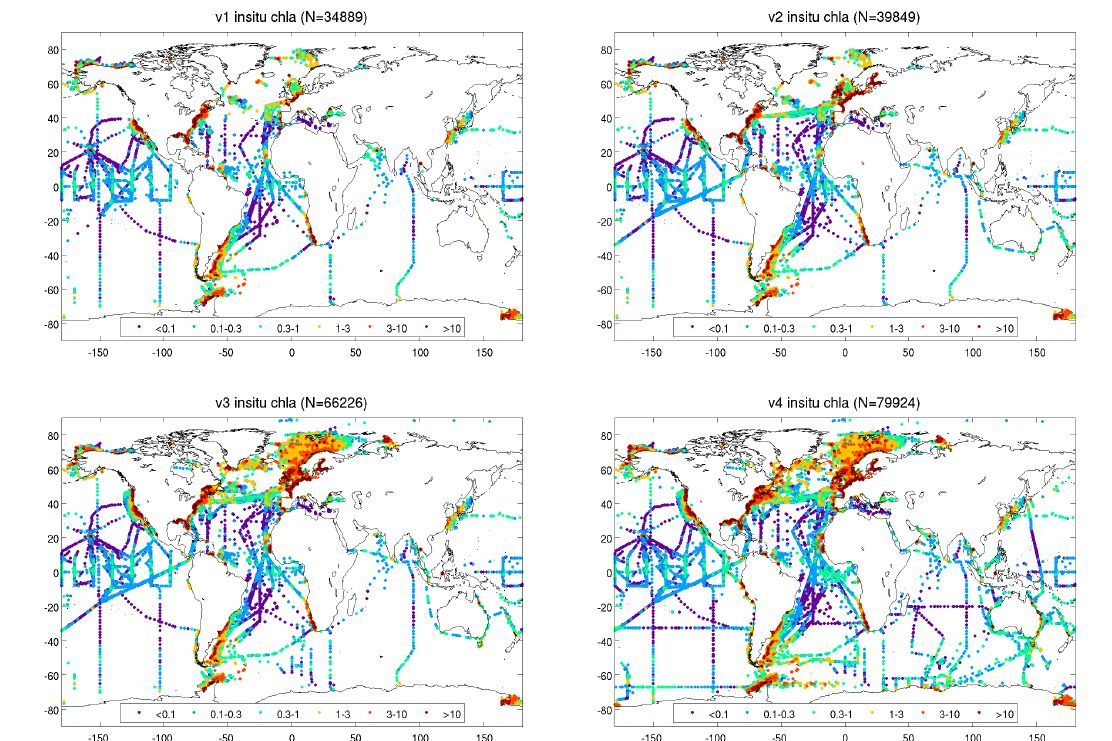
Figure 1. Global distribution of in situ chlorophyll data assembled for the four versions of OC-CCI: The colours are indicative of the values of the variables (see the colour bar); units of chlorophyll: mgm − 3